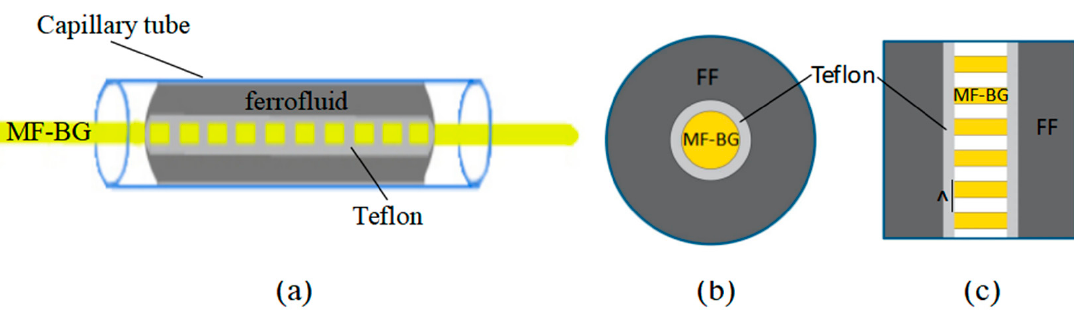
Figure 1. ( a ) The schematic diagram of the proposed MF sensor. ( b , c ) are the top view and cross-section of the structure.